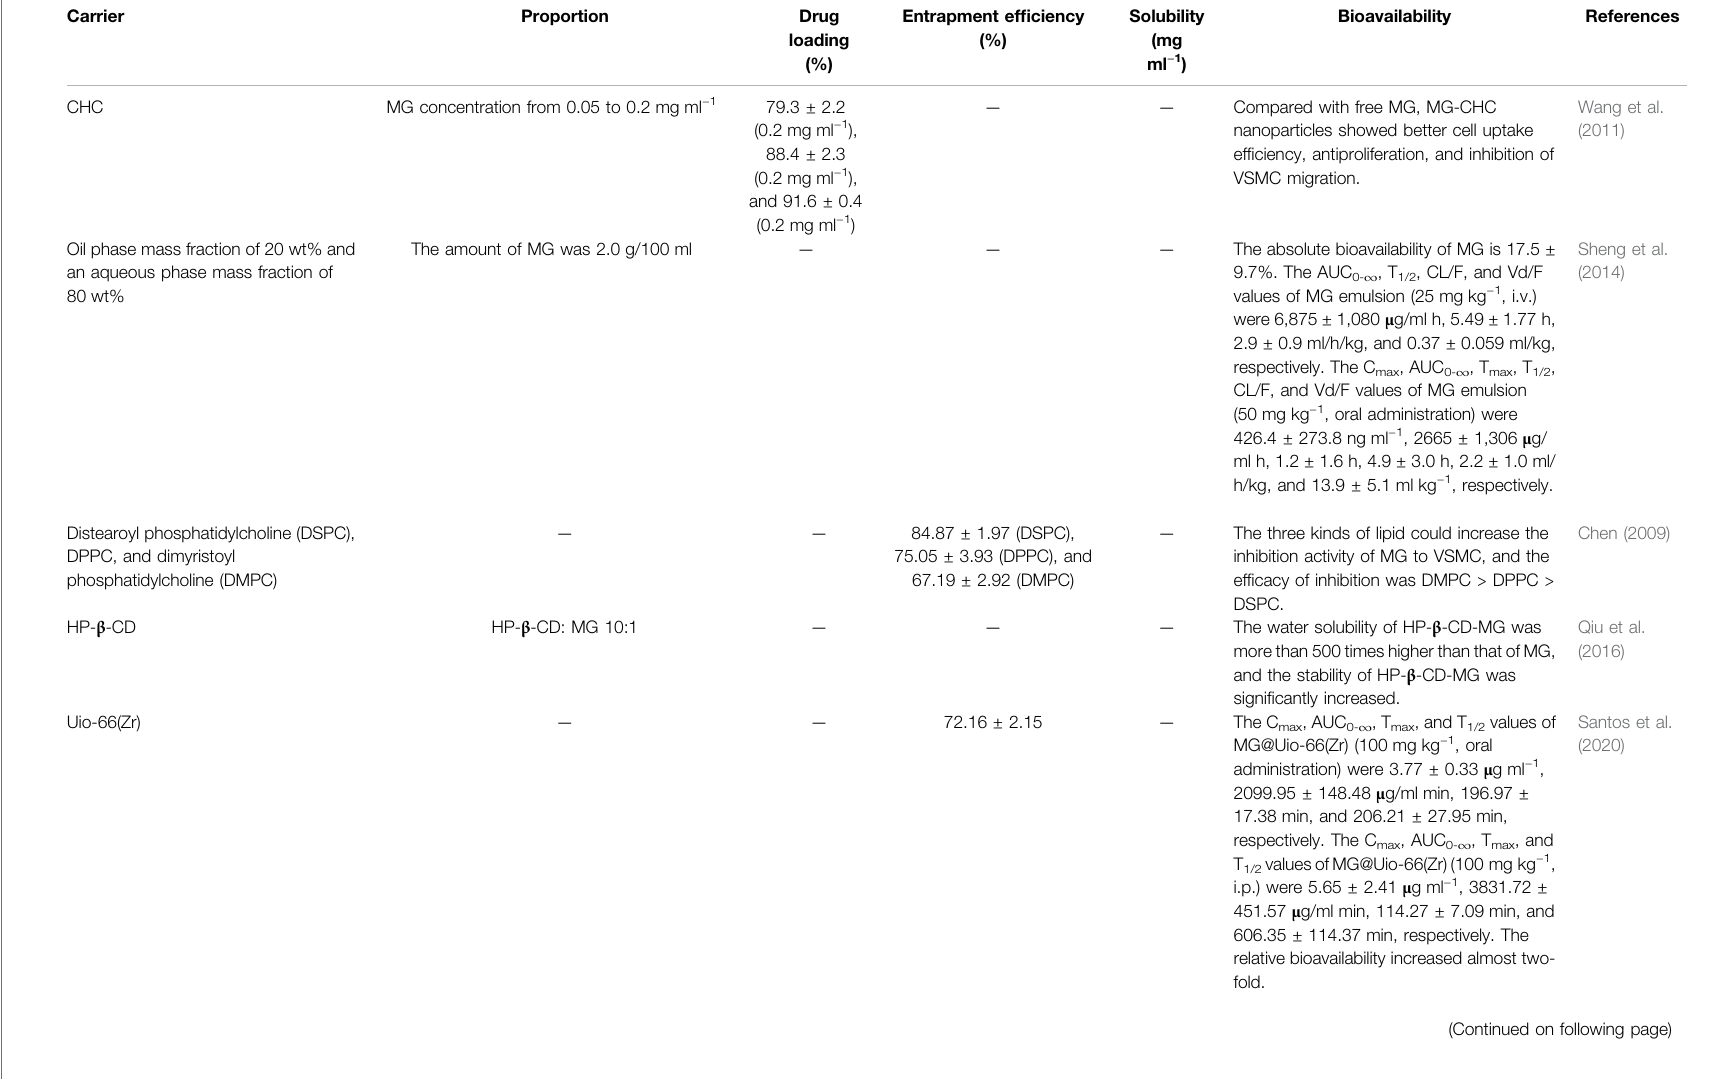
— — Compared with free MG, MG-CHC